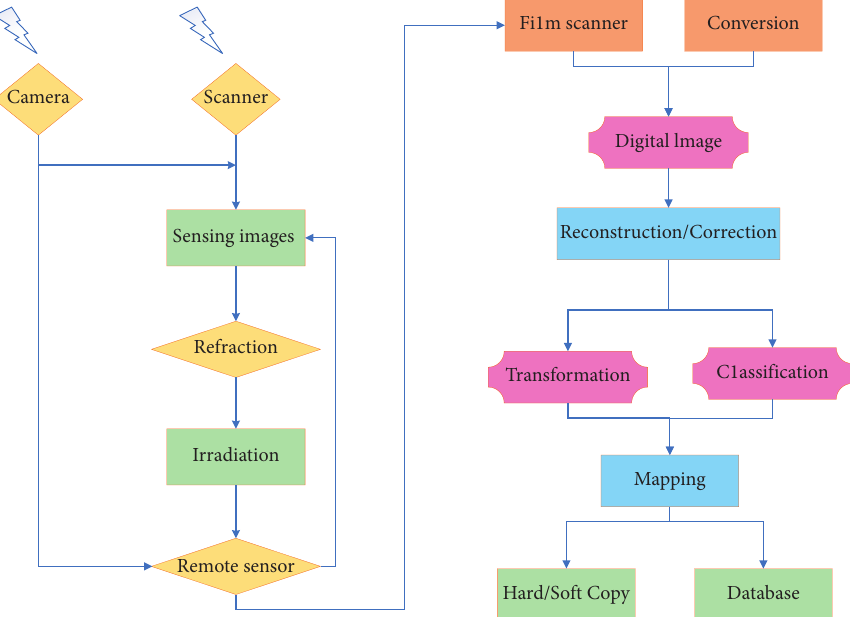
Figure 2: Preprocessing process of remote sensing data of